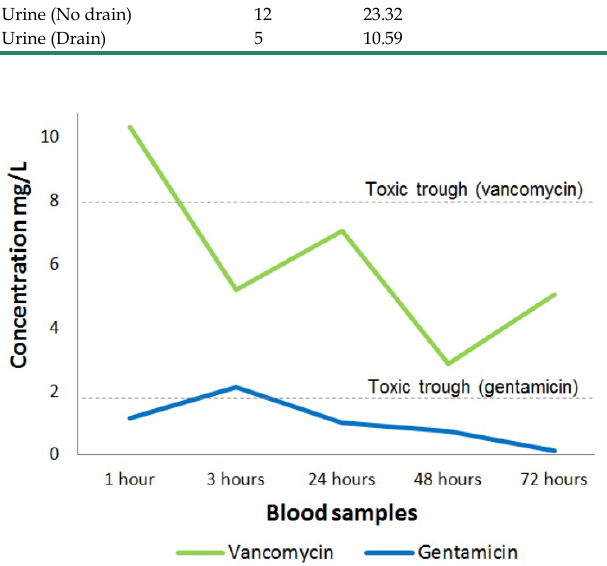
Figure 2. Peak plasma-concentrations (highest measured antibiotic concentration) of gentamicin (blue) and vancomycin (green) during the first three days post antibiotic implant with the corresponding toxic trough